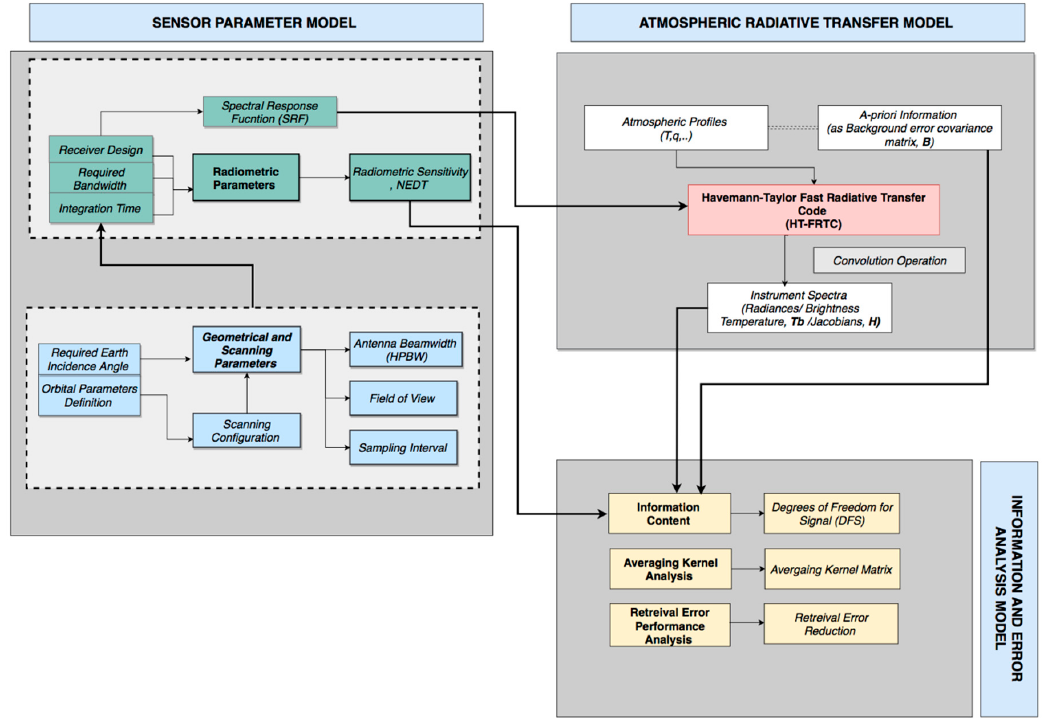
Figure 3. A schematic block diagram of the EIPS Framework, showing three important component models of the framework.